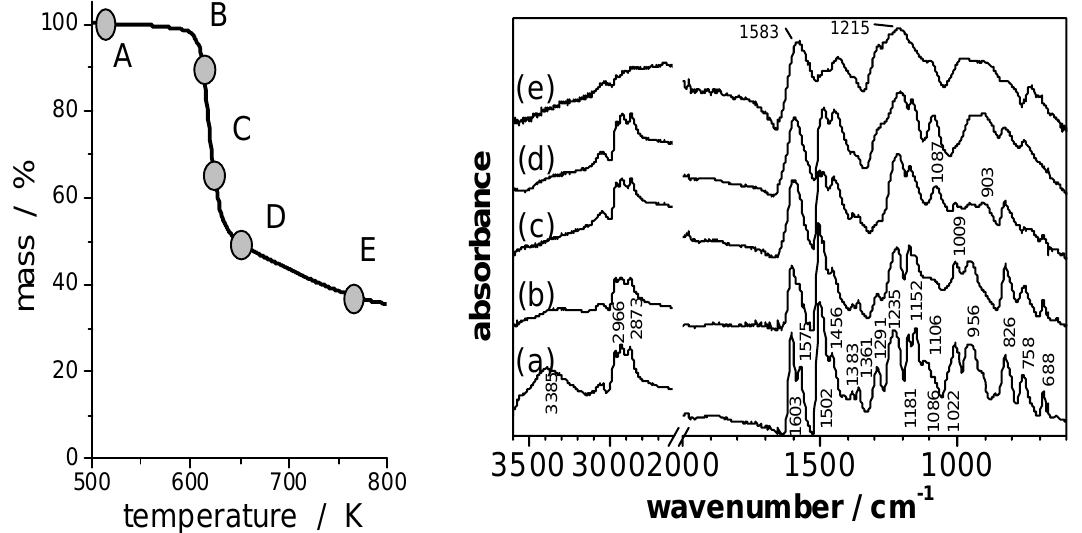
Figure 6. FTIR spectra of EP/PO4 (A, a) and of its solid pyrolysis products obtained under by heating to 10% weight loss (B, b); 35% weight loss (C, c); 53% weight loss (D, d) N 2 and to 768 K (E,